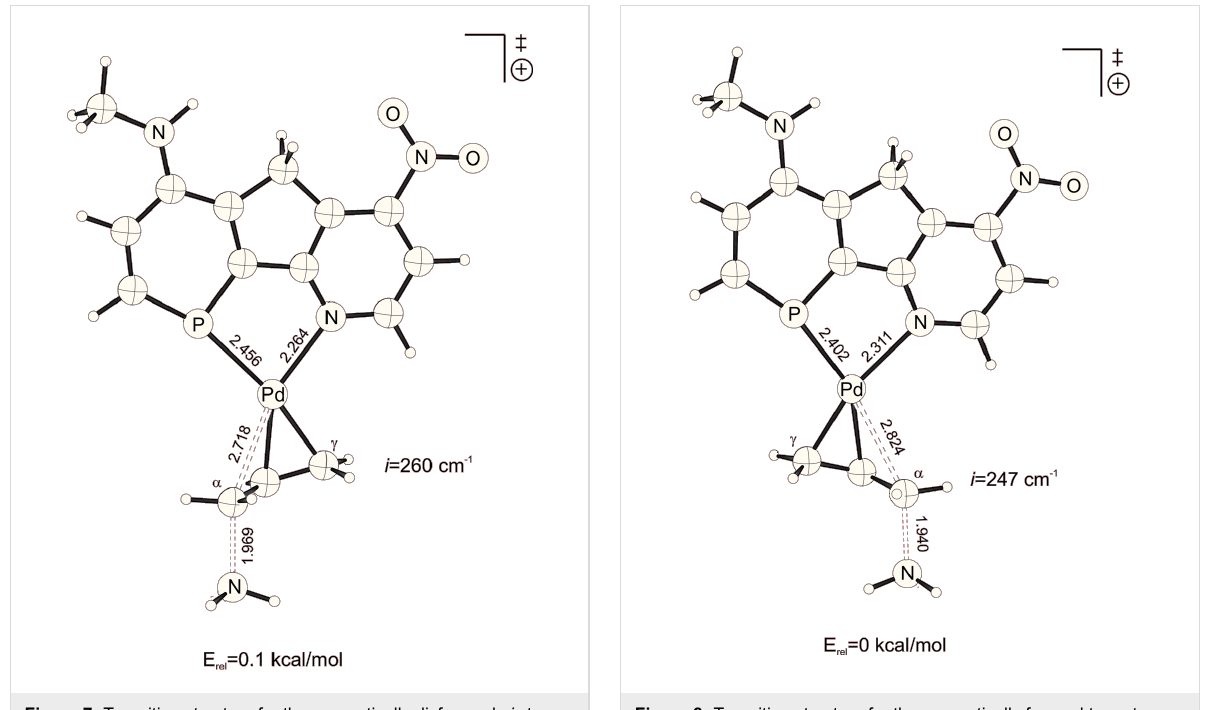
Figure 7: Transition structure for the energetically disfavored cis to phosphorus addition of ammonia at the Pd-η 3 -allylic intermediate (B3LYP/6-31G* (C, H, N, P, O), /SDD (Pd)). Bond distances are given in Å.